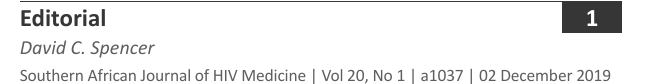
Opinion Paper Current perspectives on paediatric HIV management from the Mexico International Aids Society Conference, 2019 Mohendran Archary, Lee Fairlie, Amy Slogrove Case Report Cutaneous tuberculosis in HIV-infected individuals: Lessons learnt from a case series Vhudzani Tshisevhe, Nontombi Mbelle, Remco P.H. Peters